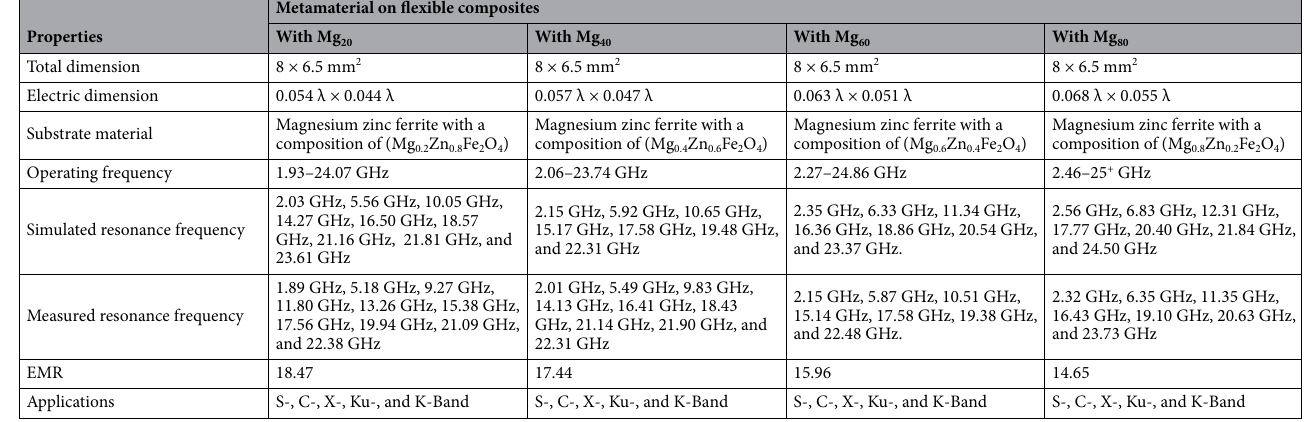
Table 5. Summary of the designed metamaterials on flexible composites.